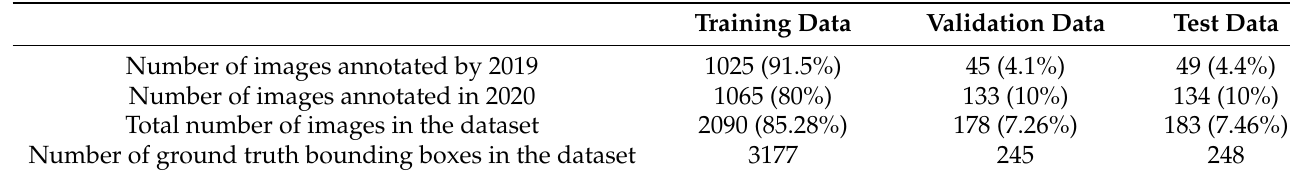
Table 1. Summary of training, validation, and test